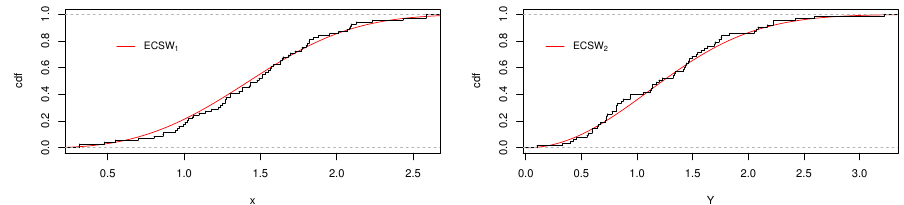
Figure 19. Plots of the cdf of first data with the fitted ECSW 1 model, and second data with the fitted ECSW 2 model.